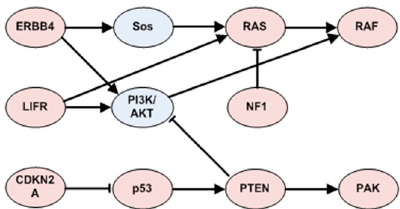
Figure 7. A concise exhibition of functional continuity among top mutated driver genes for SKCM.